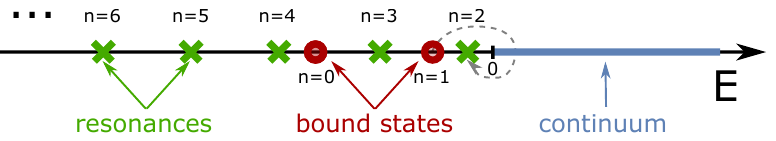
Figure 11 . Structure of the spectrum of the Schrodinger operator. For (cid:12)nite coupling there are (cid:12)nitely many bound states. When the coupling is decreased, eventually the top bound state touches the continuum and goes to another sheet, becoming a resonance. There are in(cid:12)nitely many resonances for any value of the coupling. The spectrum of dimensions is related to the energy of (cid:0)p the Schrodinger equation by (cid:1) = (cid:0) E . This map resolves the branch cut of the continuum spectrum making the bound states and the resonances indistinguishable and equally important.